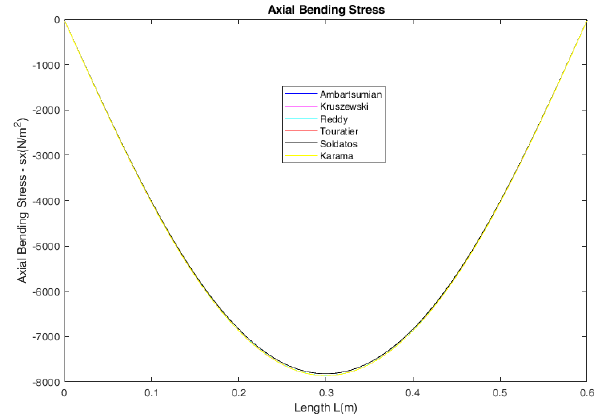
Figure 5. Comparison of axial stress σ x through the length of the beam at ( x , z = h /2 ) for all models with aspect ratio S = 30.